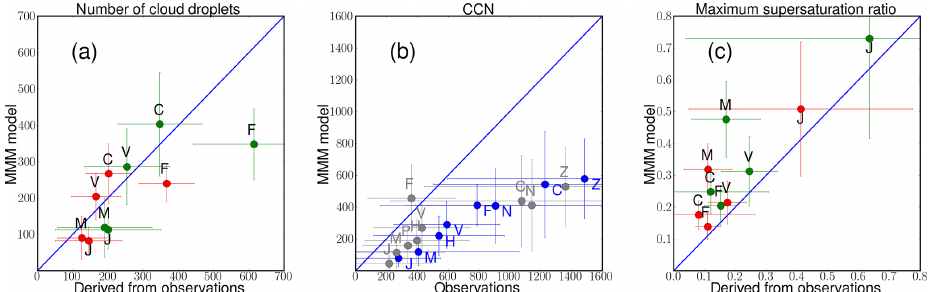
Figure 9. Scatter plot of the average of multi-model median results ( y axis) versus observationally derived results ( x axis) for (a) CDNC ( N d ) (cm − 3 ; in red for updraft velocity w = 0 . 3ms − 1 and in green for updraft velocity w = 0 . 6ms − 1 ); (b) CCN at supersaturation 0.2% (gray) and CCN at maximum supersaturation (blue) with available data (cm − 3 ) . To fit the scale all CCN number concentrations at maximum supersaturation (blue symbols) have been divided by 2. Panel (c) is as panel (a) but for s max (%). The letters close to the symbols indicate the station names (C – Cabauw, F – Finokalia, H – Hyytiälä, J – Jungfraujoch, M – Mace Head, N – Noto Peninsula, P – Puy de Dôme, V – Vavihill, Z –